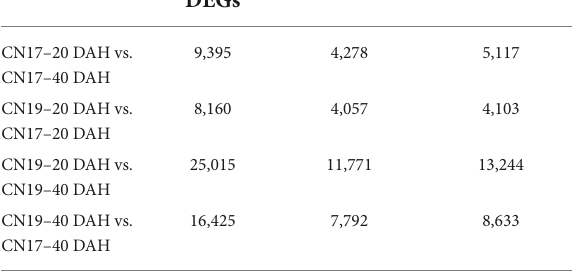
TABLE 1 Comparison of DEGs in CN17 and CN19 at 20 DAH and 40